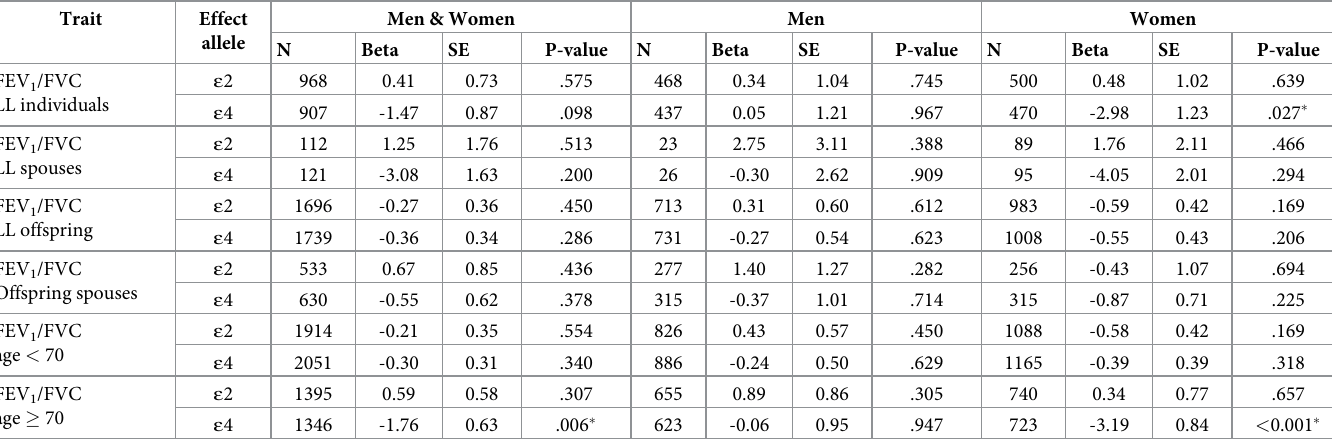
Table 4. Associations of the APOE ε 2 and ε 4 alleles with FEV 1 /FVC in different age groups of LLFS participants. Trait Effect allele FEV 1 /FVC LL